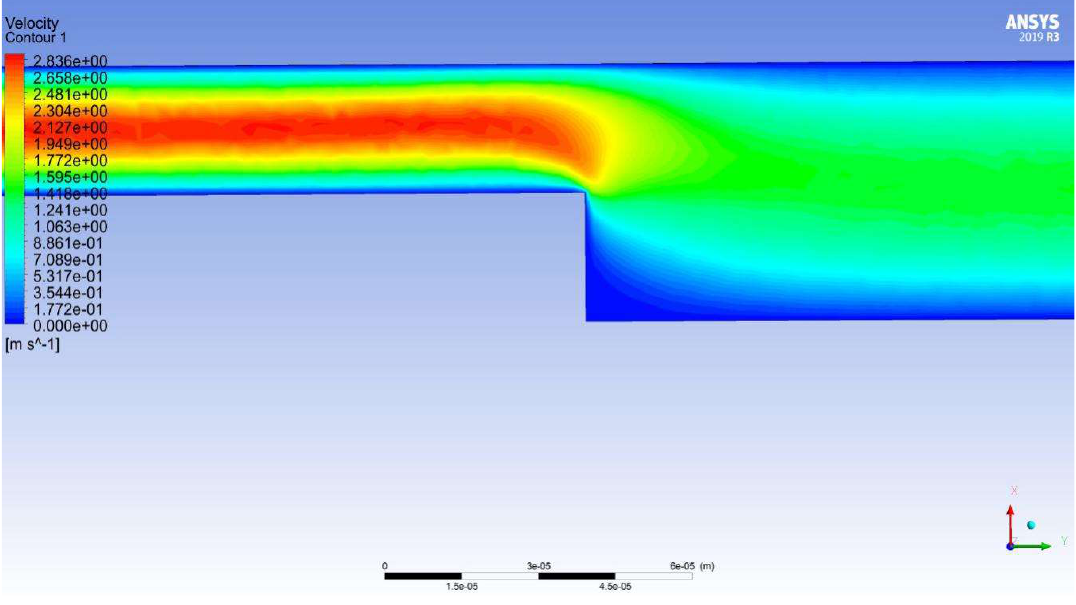
Figure 12. Velocity distribution in the Reynolds Stress turbulence model.